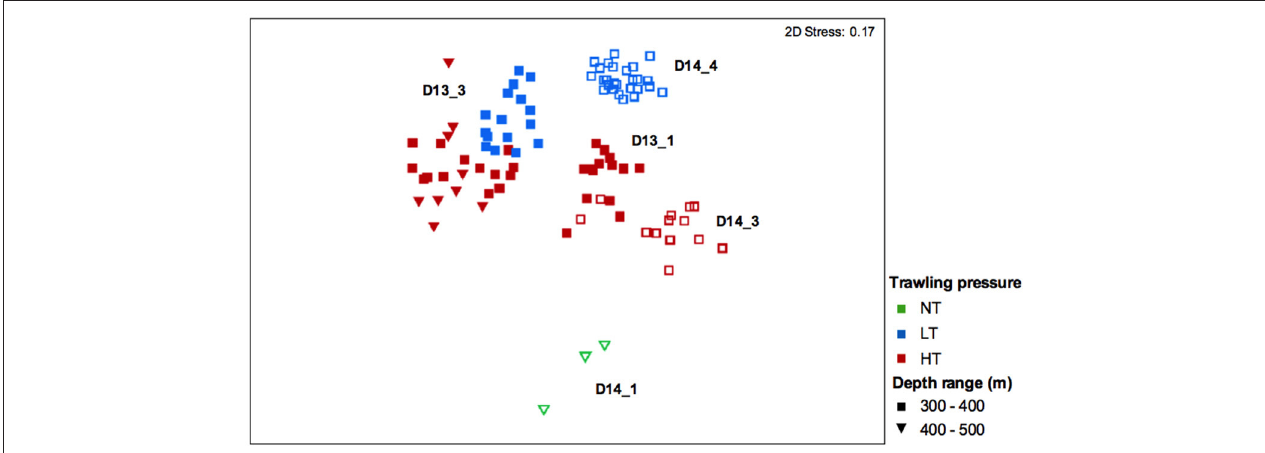
FIGURE 4 | nMDS plot for comparison of mega-epibenthic assemblages from muddy-sand sediments segments between 300–400 and 400–500m subjected to varying trawling pressure (selected dataset). NT, no trawling pressure; LT, low trawling pressure; HT, high trawling pressure. Closed symbols: 2013 segments; Open symbols: 2014 segments.